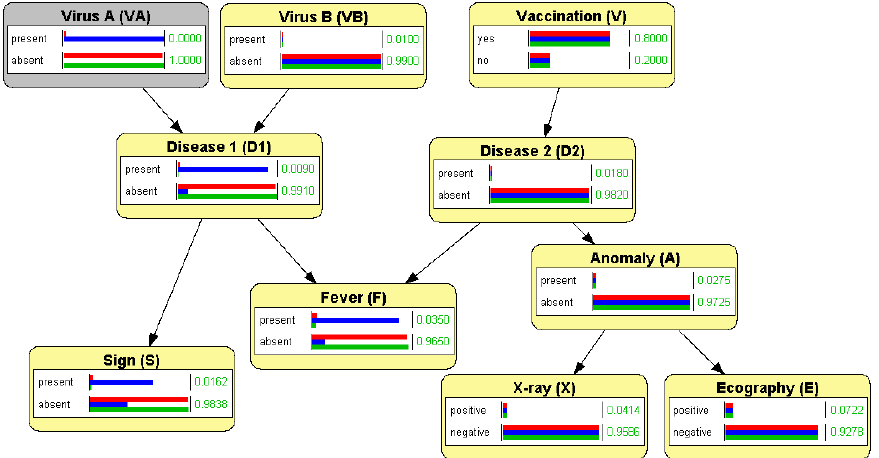
Figure 1. A Bayesian network for the differential diagnosis of two hypothetical diseases. The horizontal bars represent the probability of each state for each evidence case. We can check that V A and V B are a priori independent by introducing evidence about V A and observing that the probability of V B does not change. The same holds for the 5 variables at the right of F . In contrast, the 4 descendants of V A do depend on the evidence for this